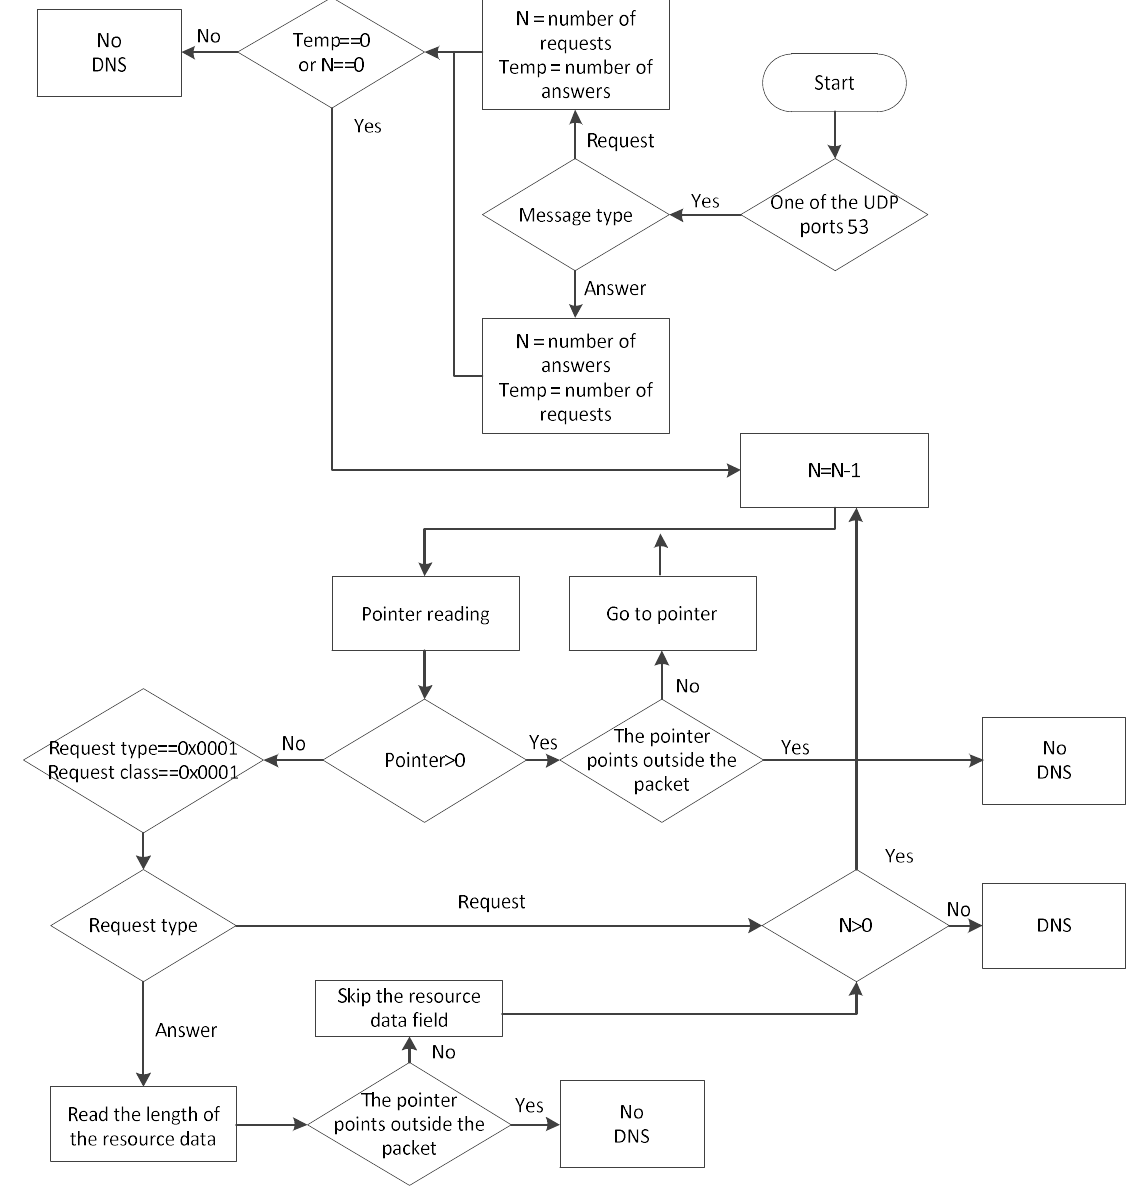
Figure 12. The algorithm of the DNS protocol detector.